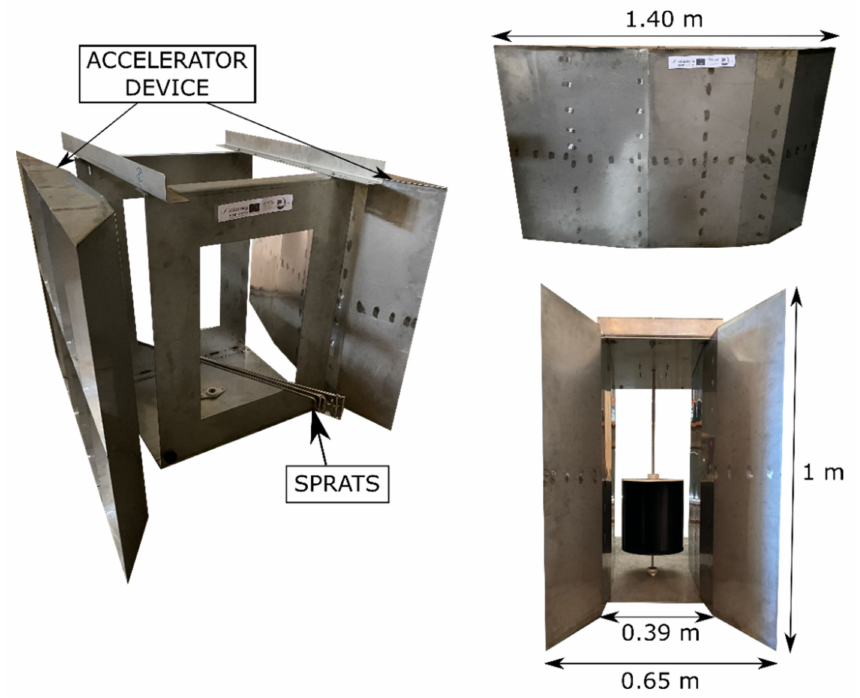
Figure 3. Geometry of the accelerator